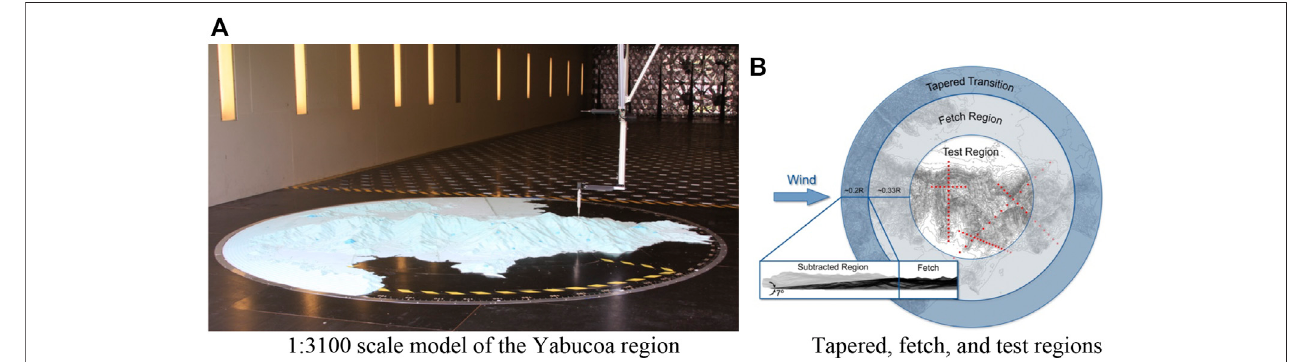
FIGURE 7 | Tapered, fetch, test regions and measurement locations of the model. (A) 1:3,100 scale model of the Yabucoa region. (B) Tapered, fetch, and test regions.